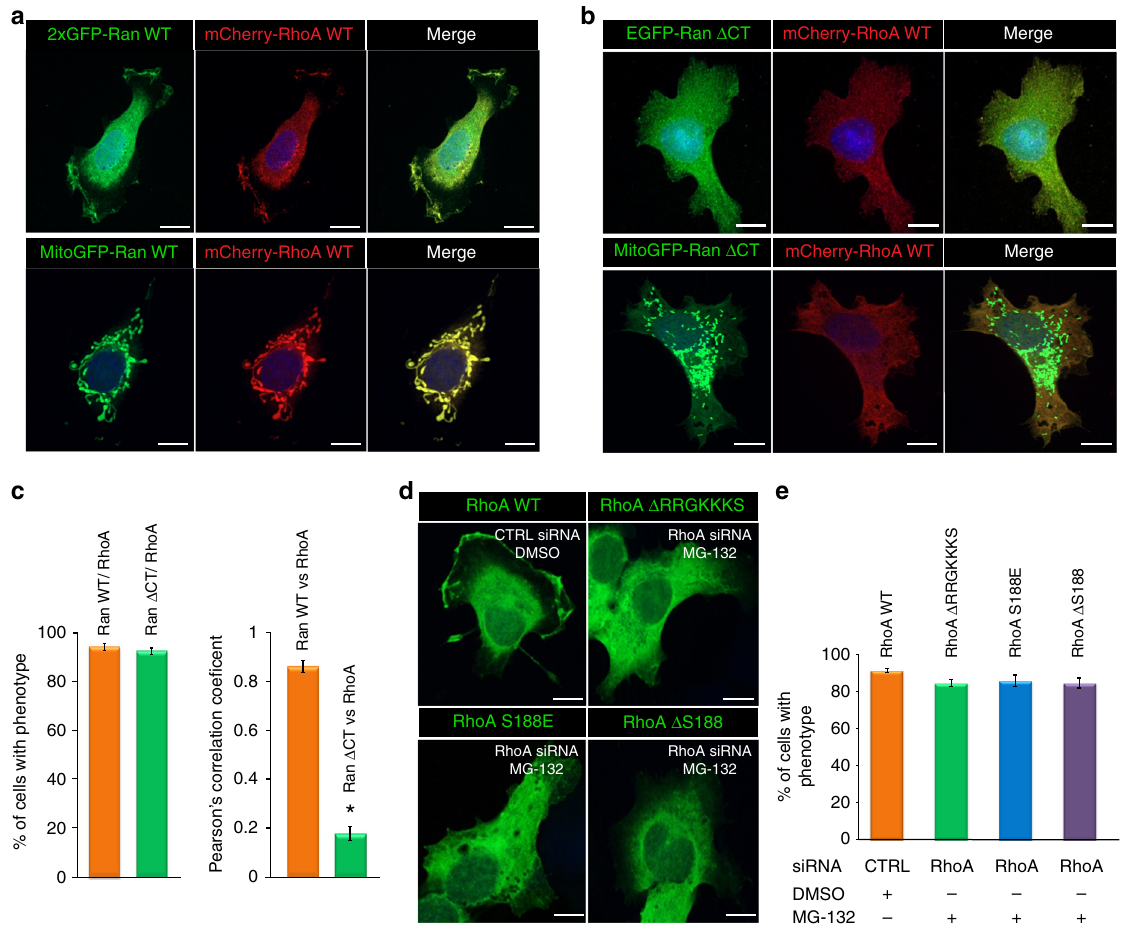
Fig. 4 Ran GTPase recruits RhoA to subcellular structures. TOV-112D cells expressing mCherry-RhoA WT were co-transfected with 2xGFP-Ran or MitoGFP-Ran WT ( a ), EGFP-Ran Δ CT (Ran without DEDDDL motif), or MitoGFP-Ran Δ CT (Ran without DEDDDL motif) ( b ). Cells were visualized by spinning disk microscopy to establish the localization of RhoA with respect to MitoGFP-Ran or MitoGFP-Ran Δ CT (Ran without DEDDDL motif). Scale bars, 10 µ m. c Left, percentage of TOV-112D cells with the corresponding phenotype as in ( a , b ) for RanWT/RhoA or Ran Δ CT/RhoA colocalization or not to the mitochondria was scored. Right, colocalization between RhoA (red) and Ran (green) represented as Pearson ’ s correlation coef fi cient and measured for individual TOV-112D cells. All values are means ± SEM from three independent experiments. P -values are based on comparisons with CTRL (Ran WT vs RhoA): using the t test: * P < 0.05 was considered statistically signi fi cant. d TOV-112D cells co-transfected with CTRL or RhoA siRNA and EGFP constructs of either RhoA (WT), RhoA Δ RRGKKS, RhoA S188E or RhoA Δ S188 treated for 2 h with 20 µ M MG-132 as indicated. Cells were visualized by spinning disk microscopy. Scale bars, 10 µ m. e Percentage of TOV-112D cells with corresponding phenotype as in ( d ) for RhoA localization at the PM or not, was